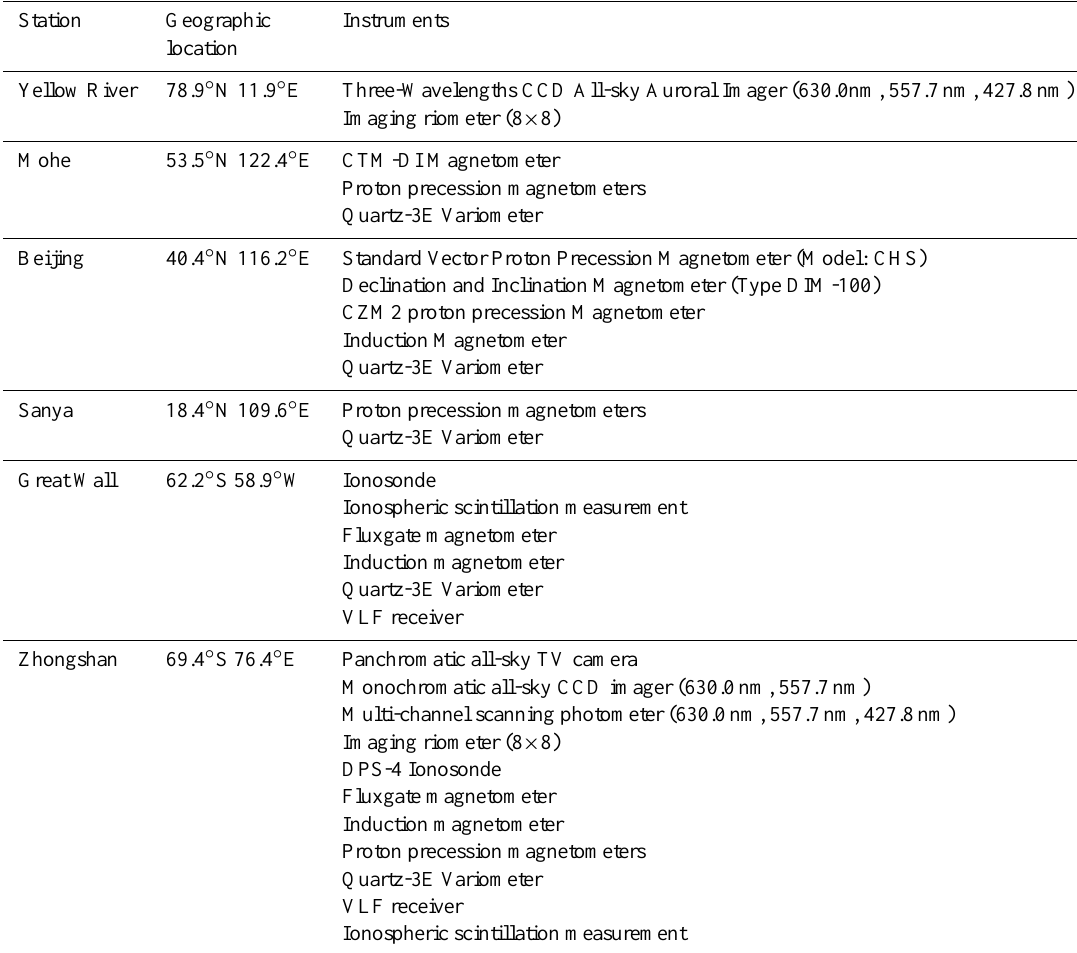
Table 1. Chinese ground stations and instrumentation in support of the combined Cluster/Double Star satellite measurements. Station Geographic